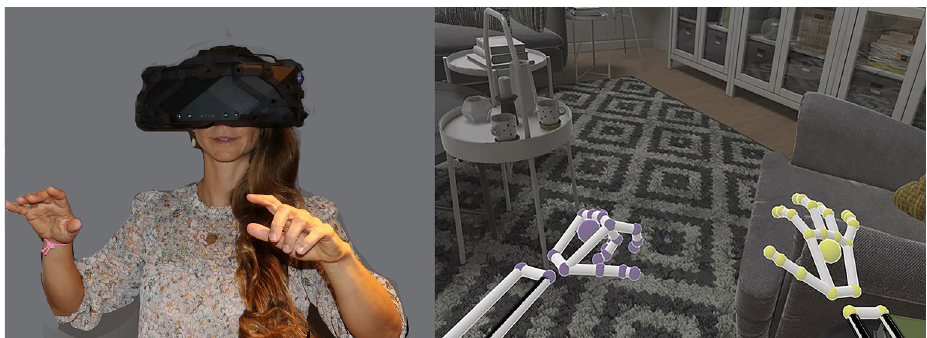
Figure 4. While wearing the XTAL VR helmet, any movements of the hands or fingers in the real world are seen by the participant in the virtual world (the image on the right is from the Architecture World demo by VRgineering.com). Photo and image copyrights Hunter Hoffman, U.W., Phase 1: measuring pain during passive VR vs. during interactive cyberhands avatar VR. For the passive VR condition, participants received the following instructions. “ For this next part of the study, please put on the VR helmet, you will see a living room, and will look at a green chair, and a coffee table with books on it. While you are in VR doing this, you will receive another 10 s pain stimulus at one of the temperatures you have approved. In other words, we won’t go any higher than that last stimulus you approved ”. After receiving a brief thermal stimulus while in virtual reality, participants took off the VR helmet and answered the pain ratings, using the pen and paper GRS pain and presence ratings. The pain ratings and subsequent instructions phase lasted approximately 5 min, and served as the “wash out” period between VR treatments, to help minimize car- ryover effects. Participants received the following instructions for the Phase 1 interactive embodied cyberhand avatar VR analgesia condition. “ For this next part of the study, please put on the VR helmet, you will see a living room, and will look at a green chair, and a coffee table with books on it. Please reach out with your hand and grab one of the virtual books, drop it on the floor, grab the second virtual book, drop it on the floor and then wiggle your fingers the rest of the time. While you are in VR doing this, you will receive another 10 s pain stimulus at one of the temperatures you have approved. In other words, we won’t go any higher than that last stimulus you approved. ” While in virtual reality, during the interactive embodied cyberhands avatar condition, participants could interact with objects in virtual reality using their hand movements in the real world (see Fig. 4). For example, they could wiggle the fingers of their cyberhand in VR by wiggling their real fingers whose detailed motion was detected by a miniature head mounted video camera attached to the XTAL VR helmet (the video camera facing outward towards the real world). With the camera based LEAP Motion system, patients did not have to hold any controllers or hardware in their hands, and did not have to wear cybergloves. The patient wearing virtual reality goggles could see their virtual hands in the virtual living room, and could use their cyberhands to interact with virtual objects in the computer generated world (pick up virtual books and drop the books onto the virtual living room floor, see Fig. 4). All participants were able to perform all tasks. Afterwards, they took off the VR helmet and answered the pain ratings, using the pen and paper GRS pain and presence ratings. Phase 2: measuring the amount of attention used by passive VR with no avatar vs. interactive avatar cyberhands VR. After Phase 1, the thermal pain stimulator was removed from the participants foot, and participants were told that Phase 1 was now over, and they received the following instructions. “You have just completed Phase 1 and you can now remove the thermal pain stimulator from your foot. Please take off the thermal stimulator and put your shoe back on now. There are no more pain stimuli, but we will now begin Phase 2 of the study. In Phase 2, no pain stimuli will be administered. Instead you will go into virtual reality again and while you are in the virtual world, you will monitor a string of numbers from 1 to 10, and will say ‘now’ any time you hear three odd numbers in a row, (the odd numbers are 1, 3, 5, 7 or 9). For example, if you hear “1, 9, 3”, you would say “now”. The researcher will keep track of your answers and will be measuring your accuracy on the odd number task. You will receive a total of three divided attention tasks which each last 2 min per task. The first two minute session is with No VR. Are you ready to begin the odd number task? Just say “now” any time you hear 3 odd numbers in a row. The researcher then played the pre-recorded auditory string of numbers (see below) via a digital audio file on a laptop with high quality Dolby Sound laptop speakers. The traditional odd number divided attention task 42–45 was adapted for use in the current VR study, using our own new number set (shown below) customized for the present study (with 10 odd number triads during a 2 min session).